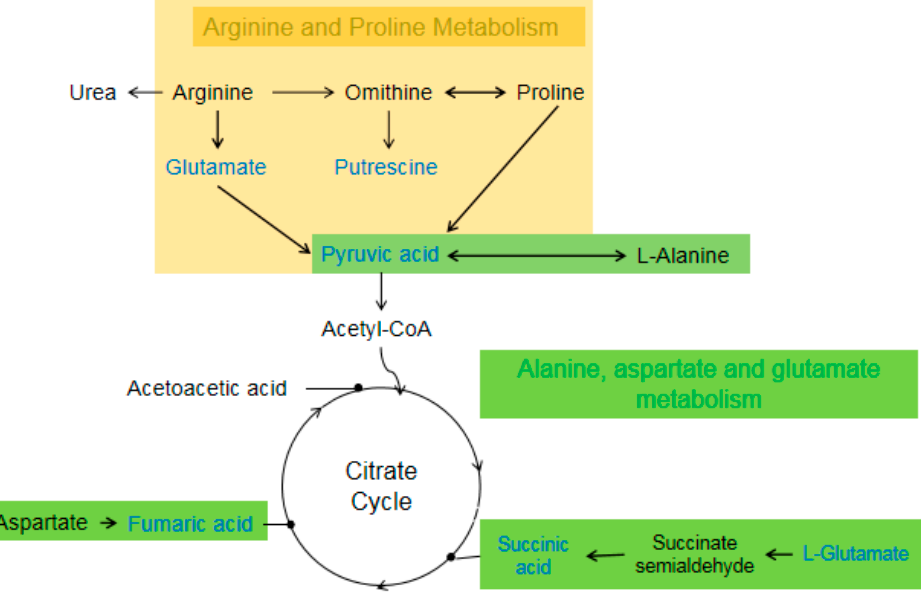
Figure 5. Di ff erential metabolites between T6_F vs. T6_C are located in Arginine, Proline, Alanine, Aspartate, and Glutamate metabolism. Blue color metalites indicates downregulated.